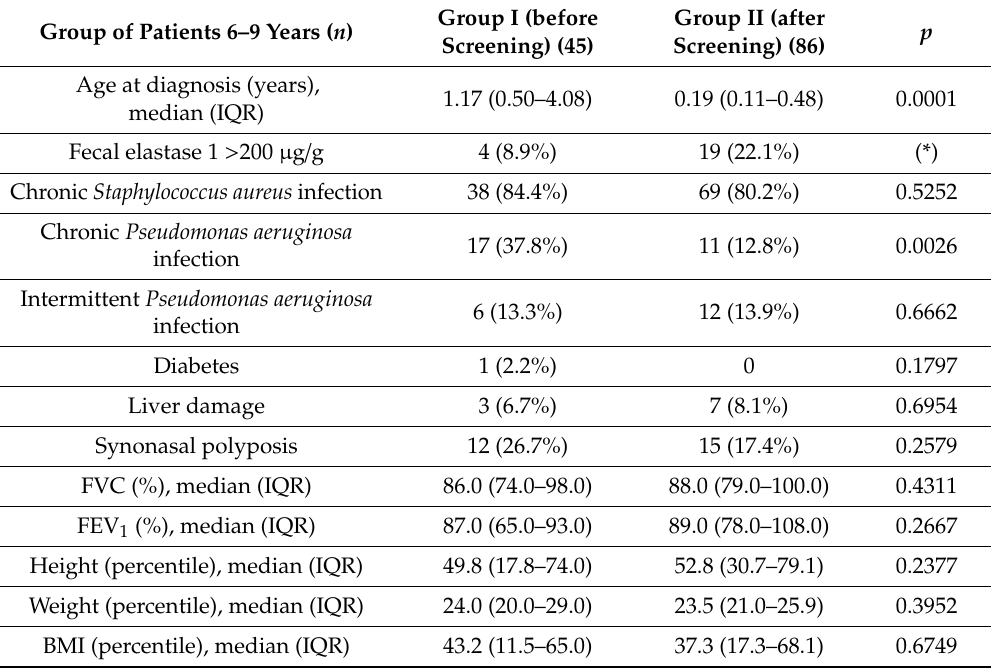
Table 2. Clinical characteristic of the cystic fibrosis patients in Groups I and II.